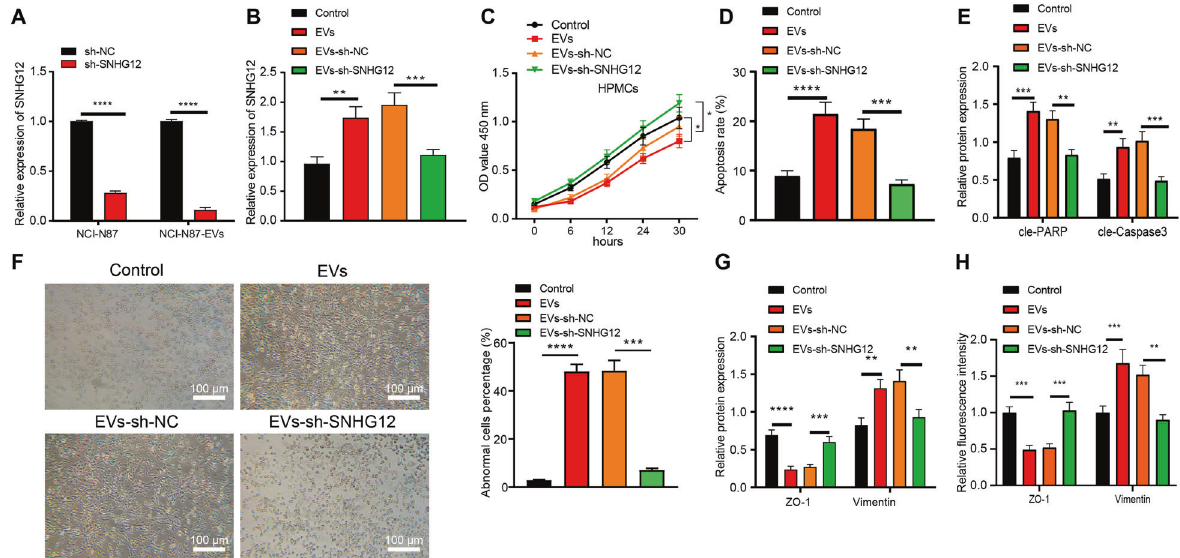
Fig. 4 Effects of EVs-SNHG12 from GC cells on apoptosis and MMT of HPMCs. A SNHG12 expression pattern in NCI-N87 cells and NCI-N87- EVs measured using RT-qPCR. B SNHG12 expression pattern in HPMCs after co-culture detected using RT-qPCR. C Cell viability of HPMCs after co-culture monitored using CCK-8. D The apoptosis of HPMCs after co-culture examined using fl ow cytometry. E The expression patterns of cleaved PARP and caspase-3 in HPMCs after co-culture determined by western blot analysis. F HPMC morphology observed by an inverted microscope (left, scale bar = 100 µm) and the proportion of abnormal cells (right). G The expression patterns of ZO-1 and Vimentin in HPMCs after co-culture measured using western blot analysis. H The expression patterns of ZO-1 and Vimentin in HPMCs after co-culture measured using immuno fl uorescence. * p < 0.05, ** p < 0.01, *** p < 0.001, **** p < 0.0001. The experiment was conducted three times